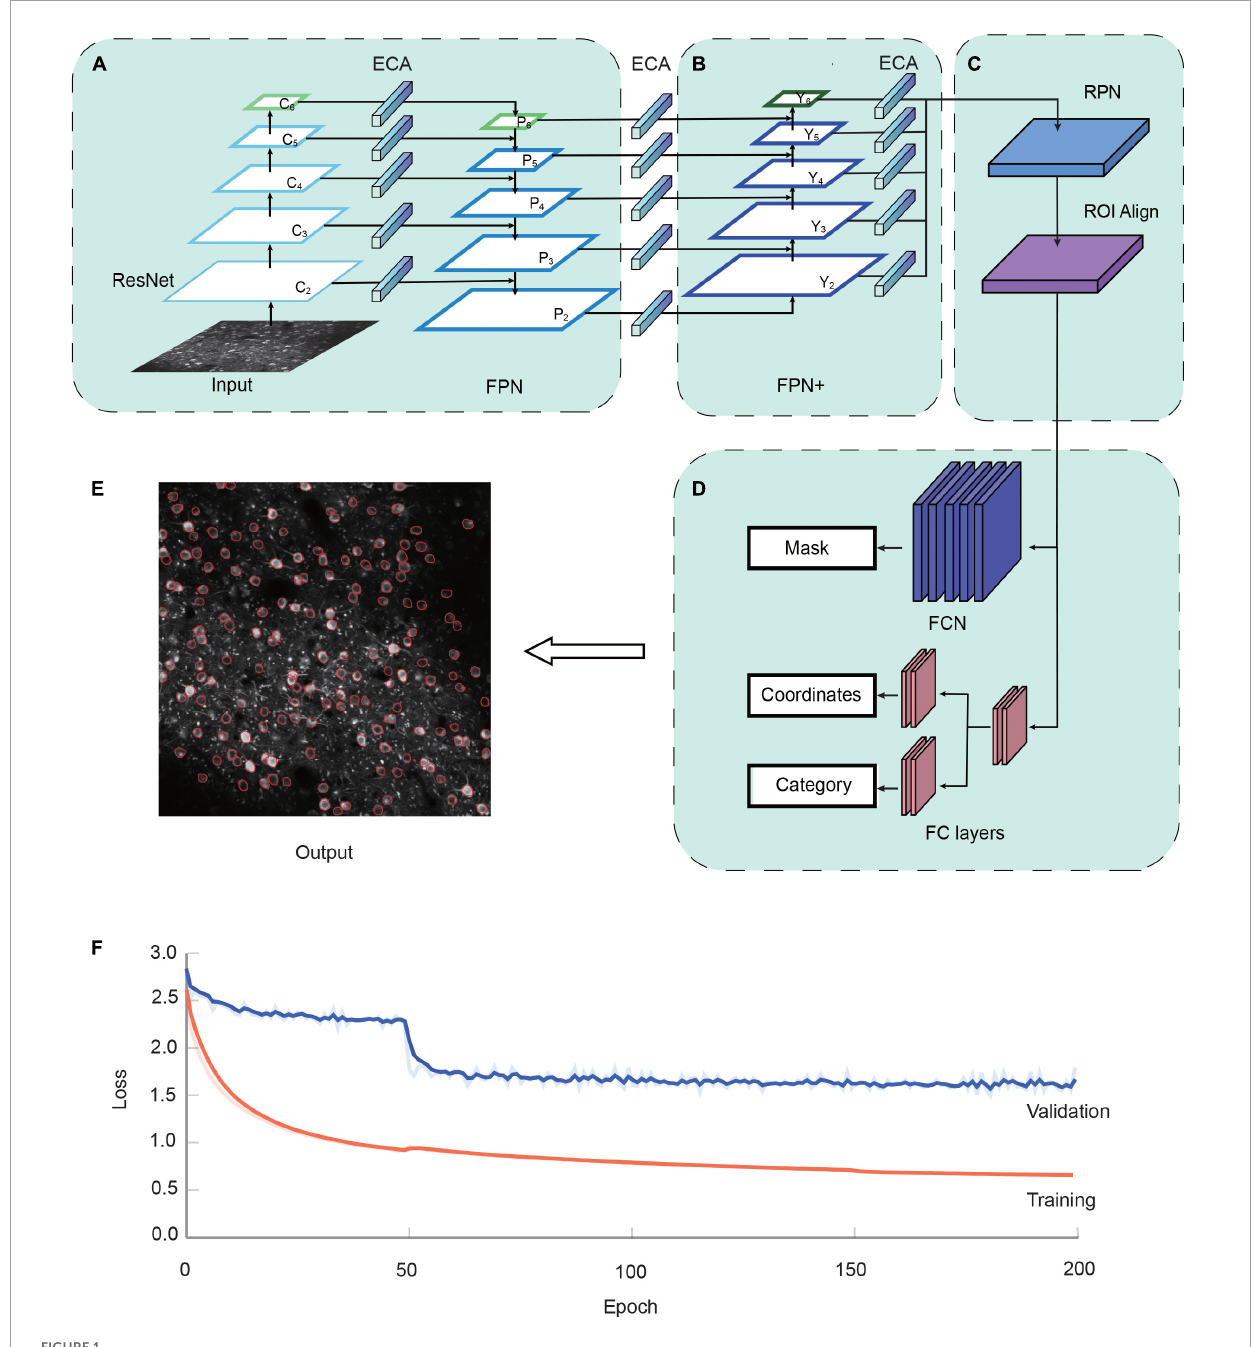
FIGURE1 The NeuroSeg-II architecture. (A) The two-photon Ca 2 + image is input to the network. ResNet uses the down-sampling structure of the backbone, and we added one more down-sampling layer after the C5 layer. Feature pyramid network (FPN) uses each layer of the ResNet output feature to the input corresponding to the up-sampling structure. The channel attention mechanism module efficient channel attention (ECA) was added to lateral connections. (B) FPN+ uses the additional down-sampling structure to obtain input from FPN. The channel attention mechanism module ECA was added between lateral connections. (C) Region selection and feature aggregation subnetwork. Region proposal network (RPN) uses the FPN to extract the feature map, score the front and back scenes, and select the target region. Region of interest (ROI) Align matches the original image with the feature image for feature aggregation. (D) Head network consists of a parallel mask segmentation branch and a classification/regression branch. (E) Neuron segmentation result by NeuroSeg-II [data from allen brain observatory (ABO) dataset, experiment ID: 511510945]. (F) The convergence of the proposed network in the training and validation datasets is demonstrated over the course of 200 epochs using TensorBoard. Loss values were normalized to better visualize trends. Training dataset, orange; validation dataset,